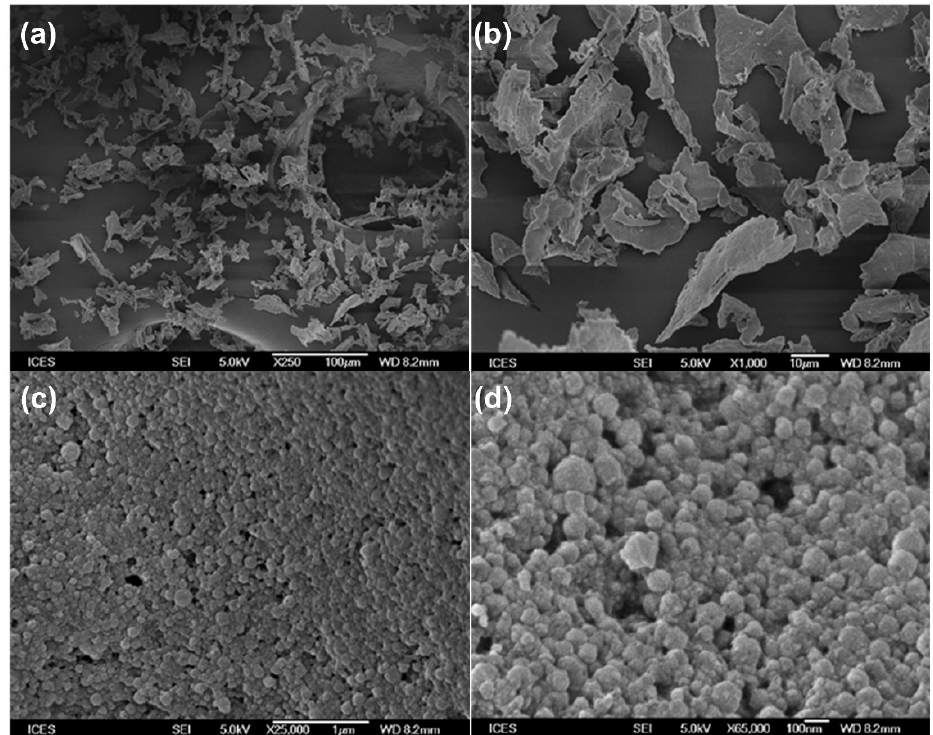
Figure 6. Scanning electron microscopic images of artemether-loaded zein nanoparticles powder at different magnifications. Image ( a ): 250×; ( b ): 1000×; ( c ) 25,000×; ( d ): 65,000×.